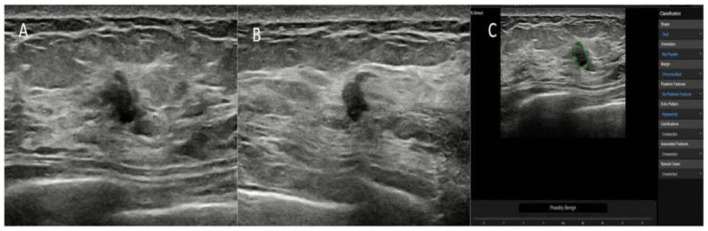
The breast lesion of an asymptomatic 46-year-old woman. (A,B) The longitudinal section and cross-section of the lesion showed a 7-mm lesion with irregular shape and ill-defined margins. The diagnosis of the experienced radiologists was a BI-RADS 4b lesion. (C) The diagnosis of the deep learning-based CAD system was a possibly benign tumor. The pathological result was fat necrosis.